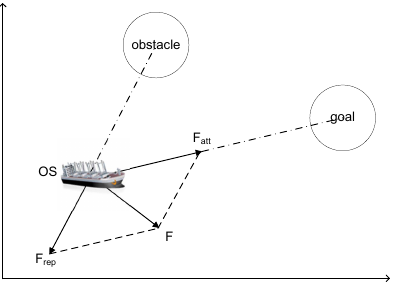
Figure 2. The force diagram of the OS In traditional artificial potential field